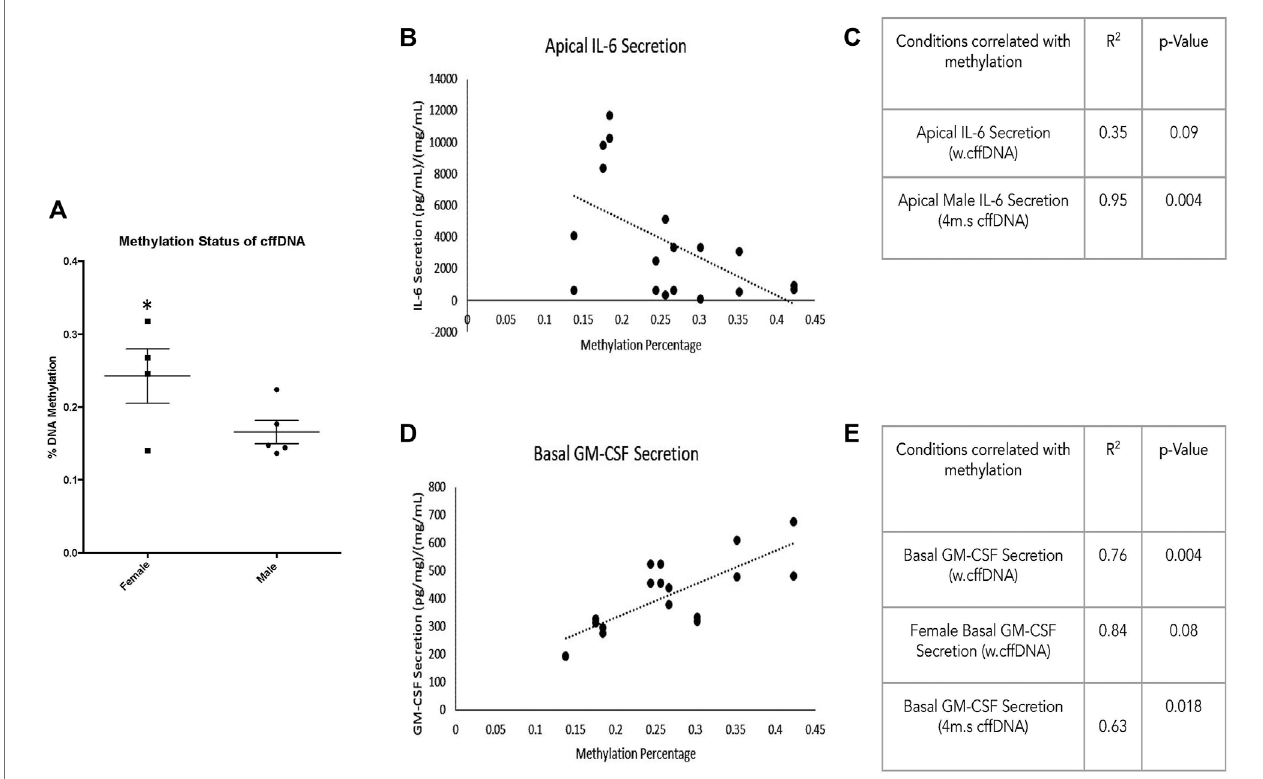
FIGURE7| FetalmembraneresponsetofetalDNArelativetomethylationpercentage. (A) Percentagemethylationofmaleand femalefetalDNA.Thecorrelationof cytokine secretion from FM correlated with percentage methylation of fetal DNA used for apical treatment. (B) Apical secretion of IL-6 regardless of fetal DNA fragment size. (C) Table illustrating the correlation betweenthepercentage ofmethylation and theapical secretion ofIL-6withw.cffDNA;theapical secretion ofIL-6from themale explants with 4 m.s cffDNA. (D) Basal GM-CSF secretion regardless of fetal DNA size is used for treatment. (E) Table illustrating the correlation between the percentage of methylation and the basal secretion of GM-CSF of FM treated with w. cffDNA; the basal GM-CSF secretion of FM treated with 4 m.s. cffDNA; the basal secretion of GM-CSF from the female explants treated with w.cffDNA.